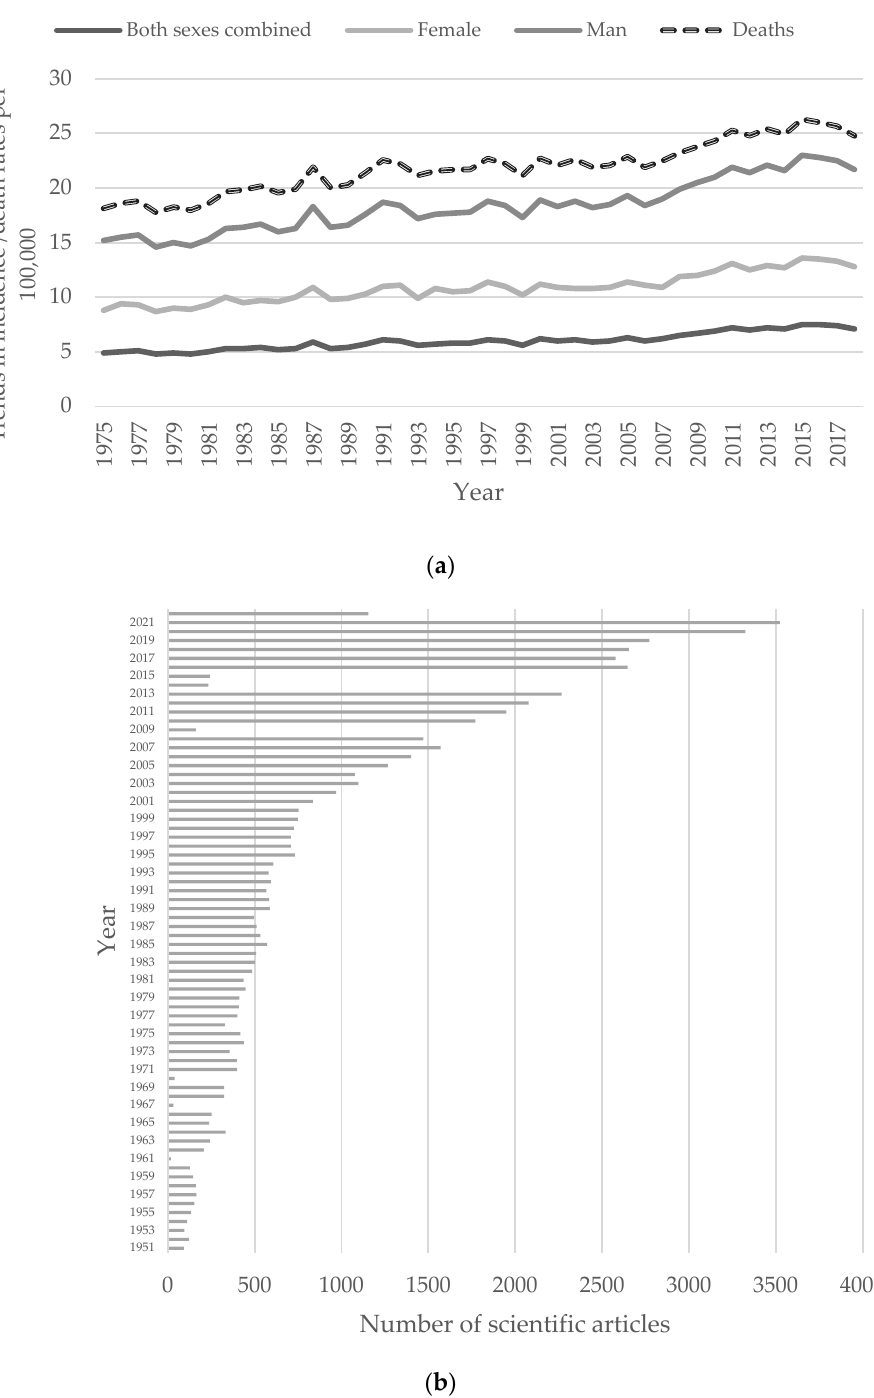
Figure 1. Multiple myeloma statistics. ( a ) Multiple myeloma trends in incidence or death rates. Data sources: Surveillance, Epidemiology, and End Results (SEER) 9 registries, National Cancer Institute, 2021© Copyright American Cancer Society, 2018; ( b ) Scientific literature on multiple myeloma over the last few decades. Adapted from data source: PubMed. Search query: “multiple